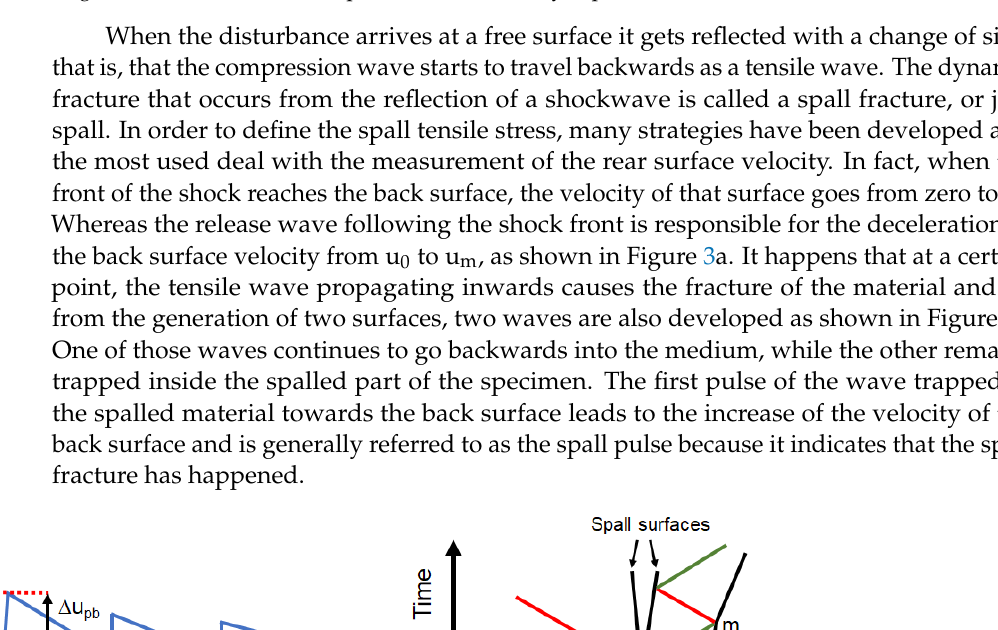
Figure 2. Helios hydrodynamic simulation of the evolution of a laser-induced shockwave inside the target for the shot S7 of the experimental case study explained below.